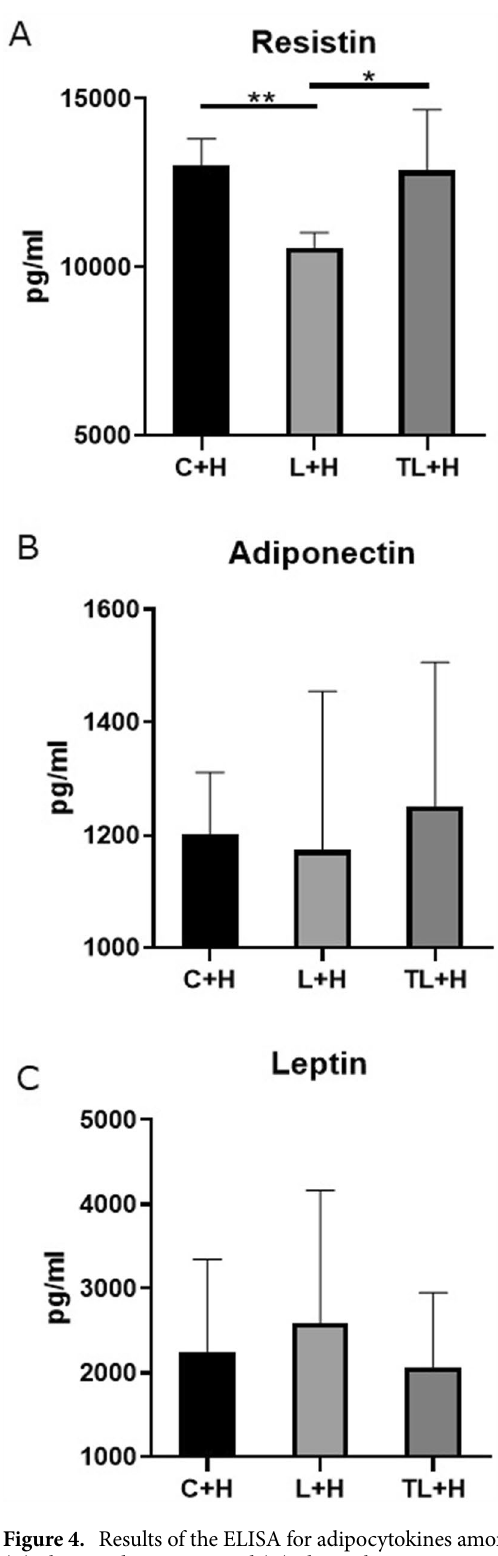
Figure 4. Results of the ELISA for adipocytokines among the different treatment groups. ( A ) Plasma resistin, ( B ) plasma adiponectin, and ( C ) plasma leptin. Data are presented as mean ± standard deviation, n = 4–7/group; **p < 0.01, *p < 0.05 based on a Welch analysis of variance with a post-hoc Games-Howell test for multiple comparisons. ( C ) C + H control + high-fat diet, HFD high-fat diet, L + H L-NG-nitroarginine methyl ester + high- fat diet, L-NAME L-NG-nitroarginine methyl ester, TL + H L-NG-nitroarginine methyl ester + tadalafil + high-fat diet, ELISA enzyme-linked immunosorbent assay